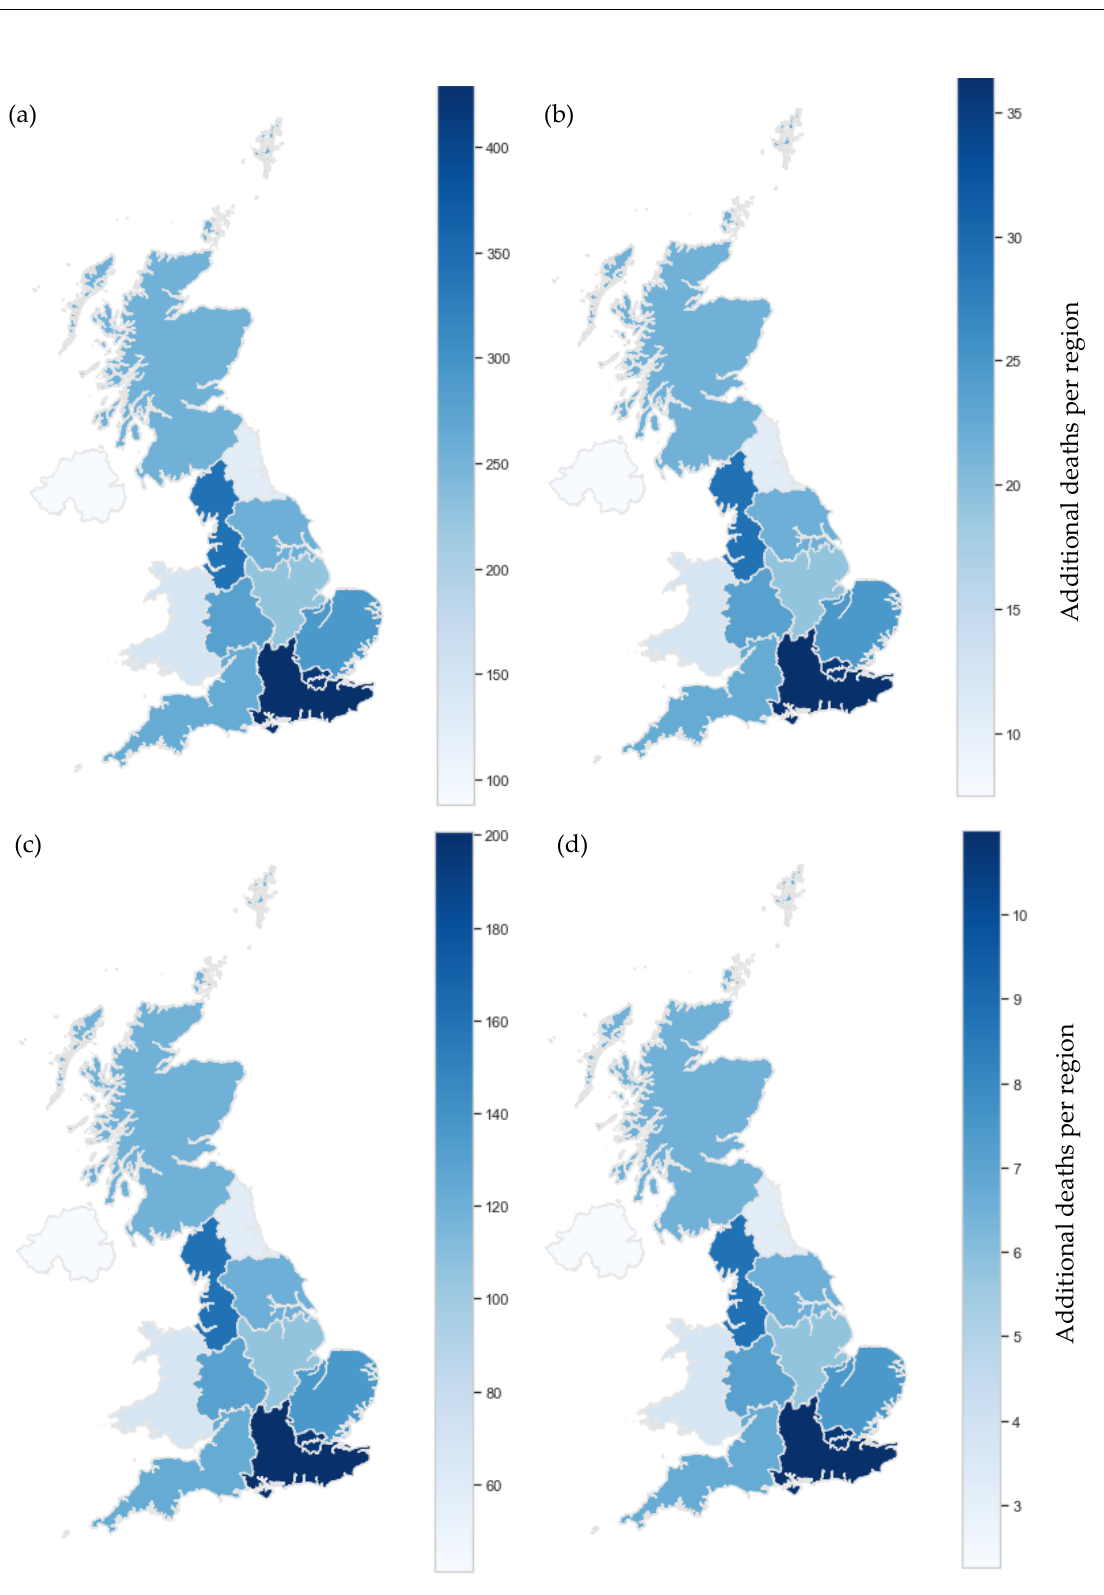
Figure 6. Upper and lower limits of average yearly cancer impact from benzene and 1,3-butadiene for 2000. ( a ) Benzene urban, ( b ) Benzene rural, ( c ) 1,3-Butadiene urban, ( d ) 1,3-Butadiene rural.